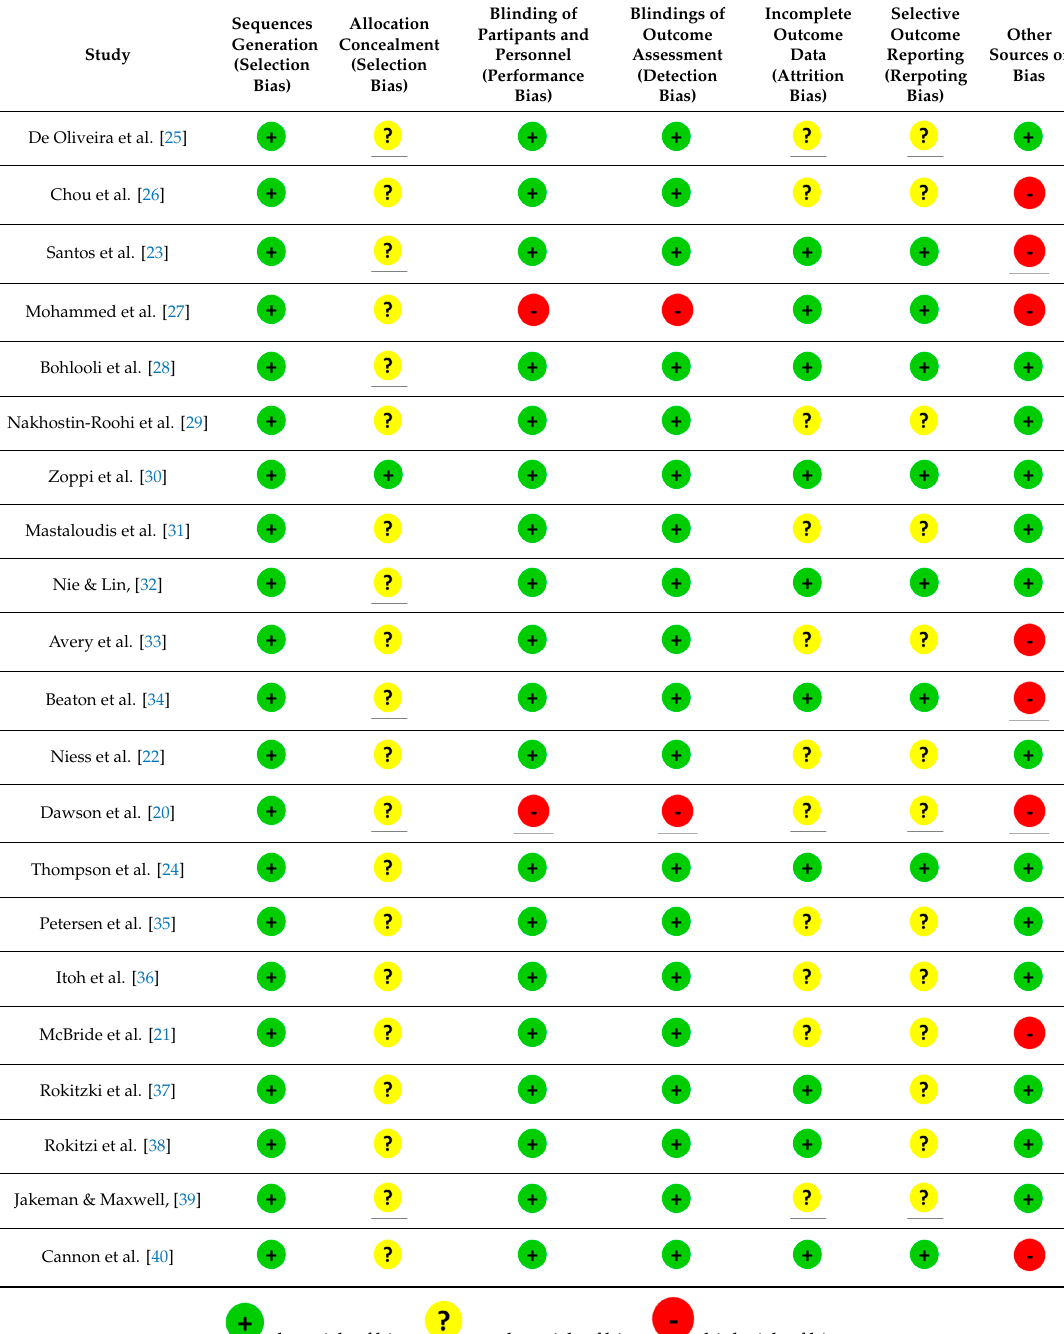
Table 1. Risk of bias graph .